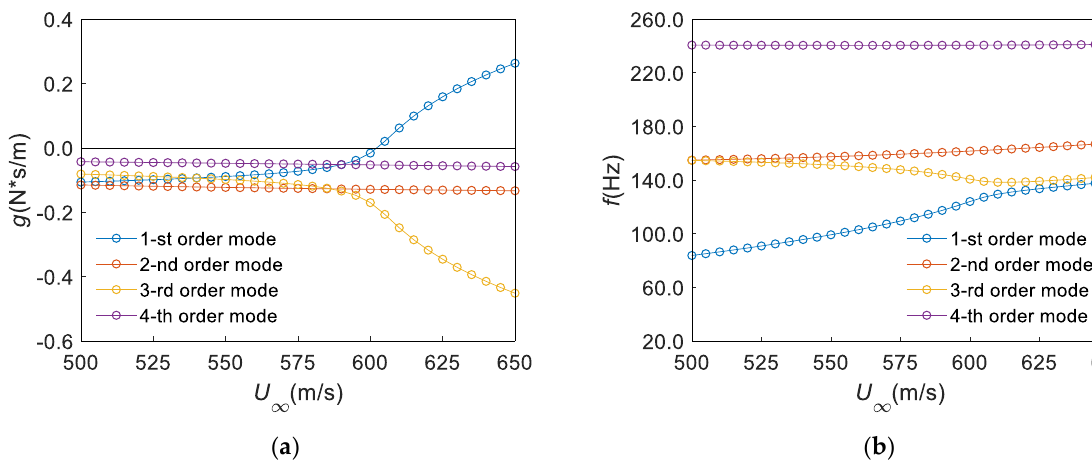
Figure 6. Results of flutter calculation (CP): ( a ) U − g , ( b ) U − f .